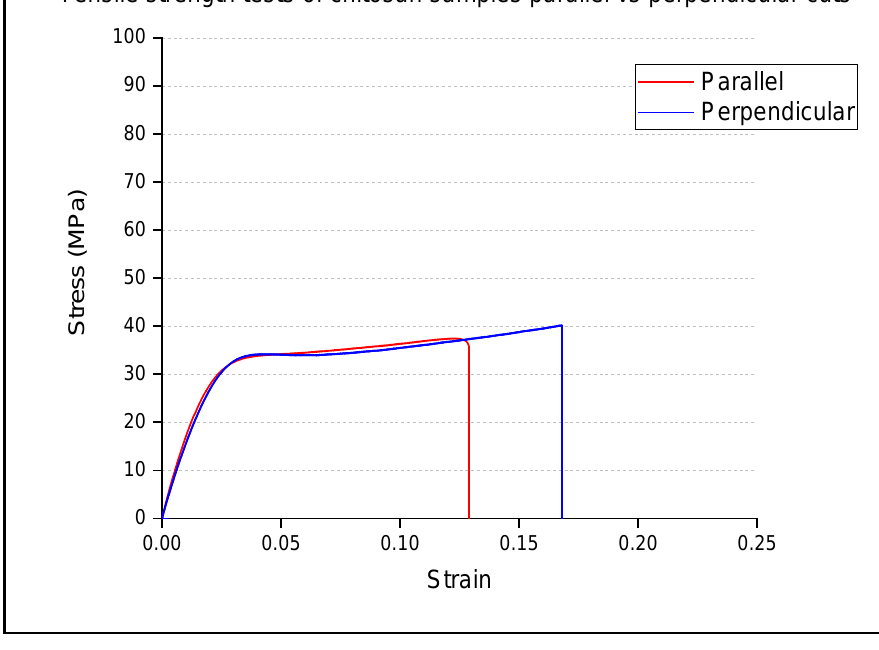
Figure 8. Median values for chitosan stress vs. strain samples cut parallel and perpendicular to the slot-die casting direction.